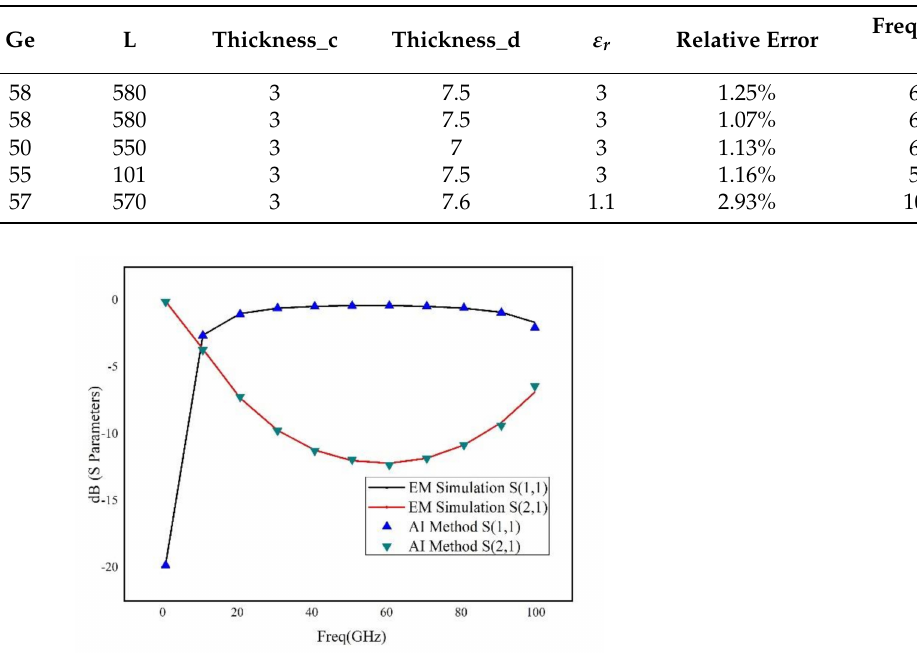
Figure 11. The comparison of dB (S Parameters) between AI method and EM